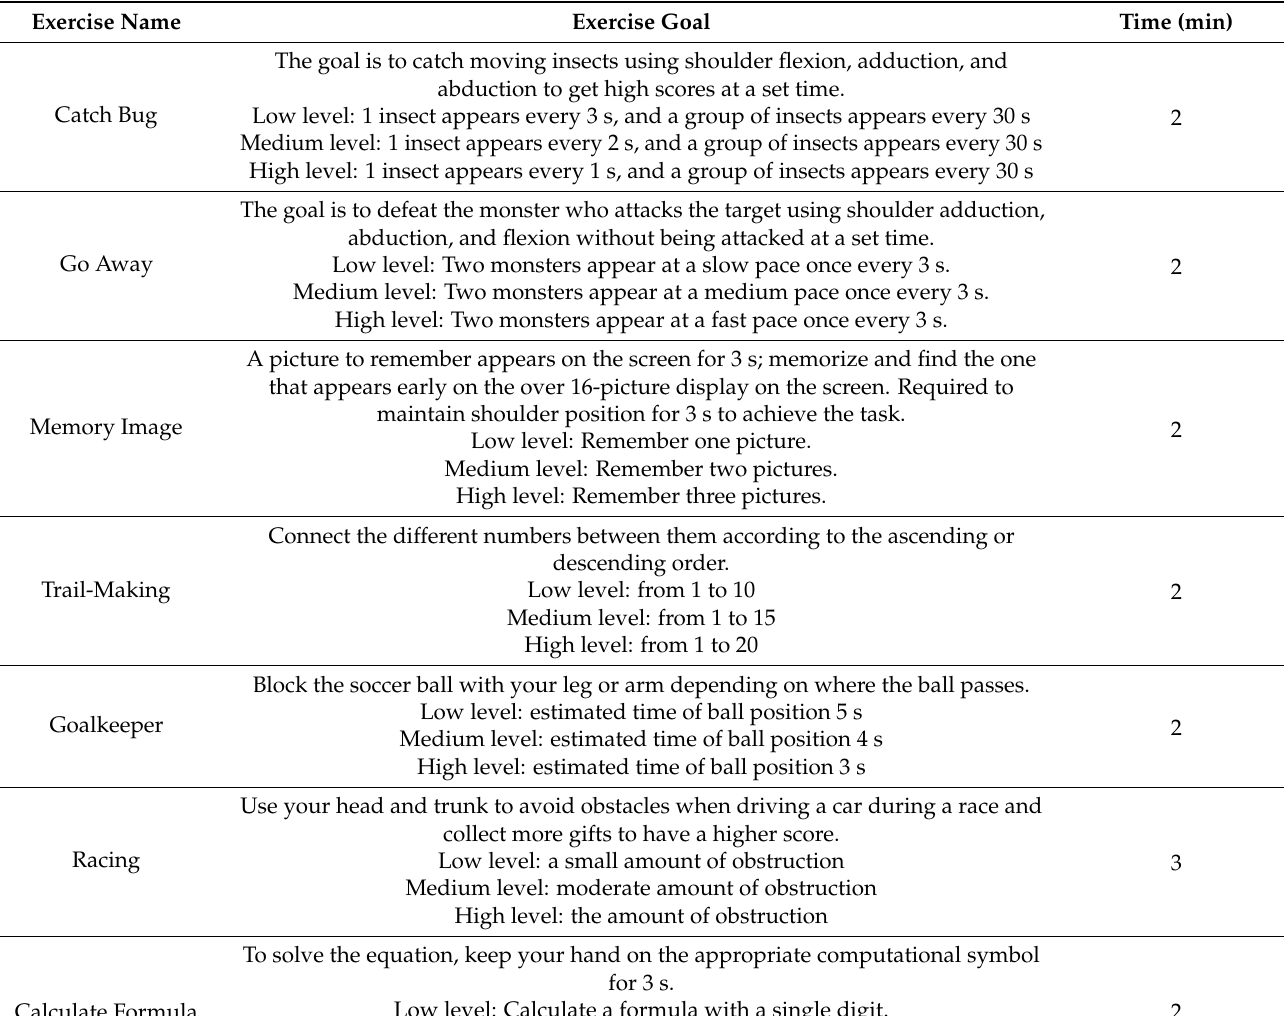
Table 1. Details and times of dual-task